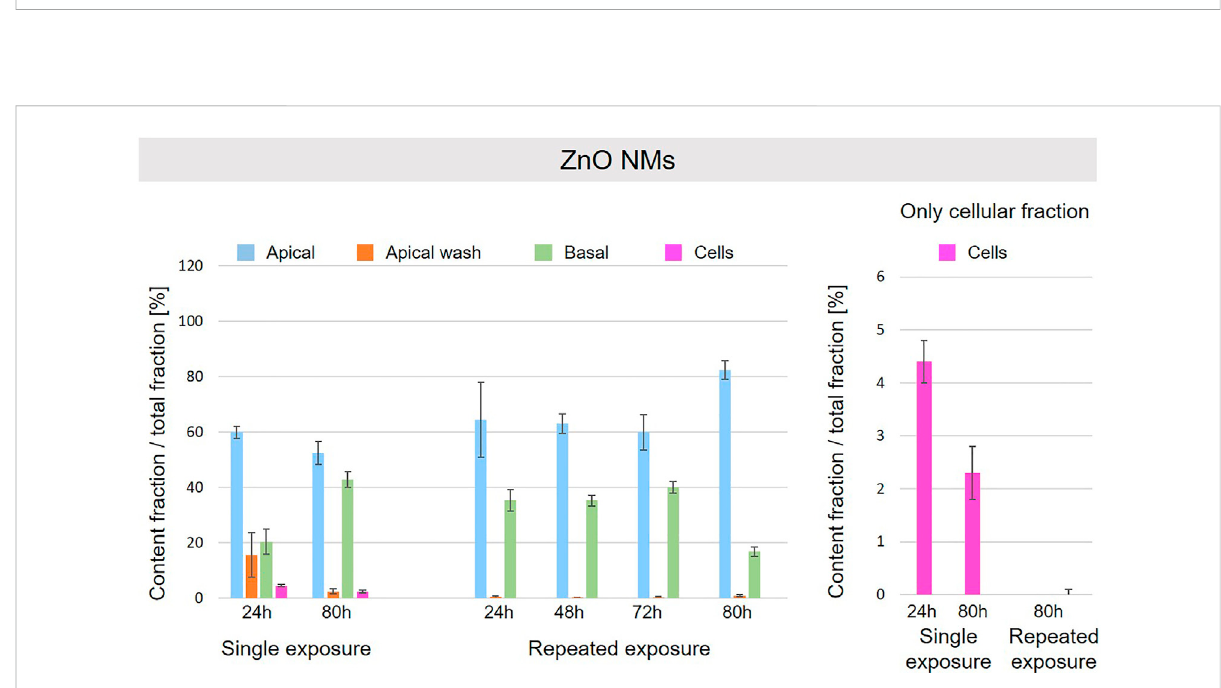
FIGURE 8 Fate of ZnO NMs at the A549 tissue barrier after single and repeated exposures. For single exposures ZnO NMs was exposed at a concentration of 100 µg/ml and the different fractions were collected after incubation for 24 and 80 h. For repeated exposures the cells were exposed repeatedly every day up to 80 h, using 25 µg/ml ZnO NMs concentration, resulting in a total exposure of 100 µg/ml and 80 h incubation time in total. Apical, apicalcellwashandbasalsampleswerecollectedafter24,48,72,and80 hofexposure.Rightside: Thisgraphonlydepictsthecellularfraction. A total of three independent experiments ( n = 3), with three single replicates each, were